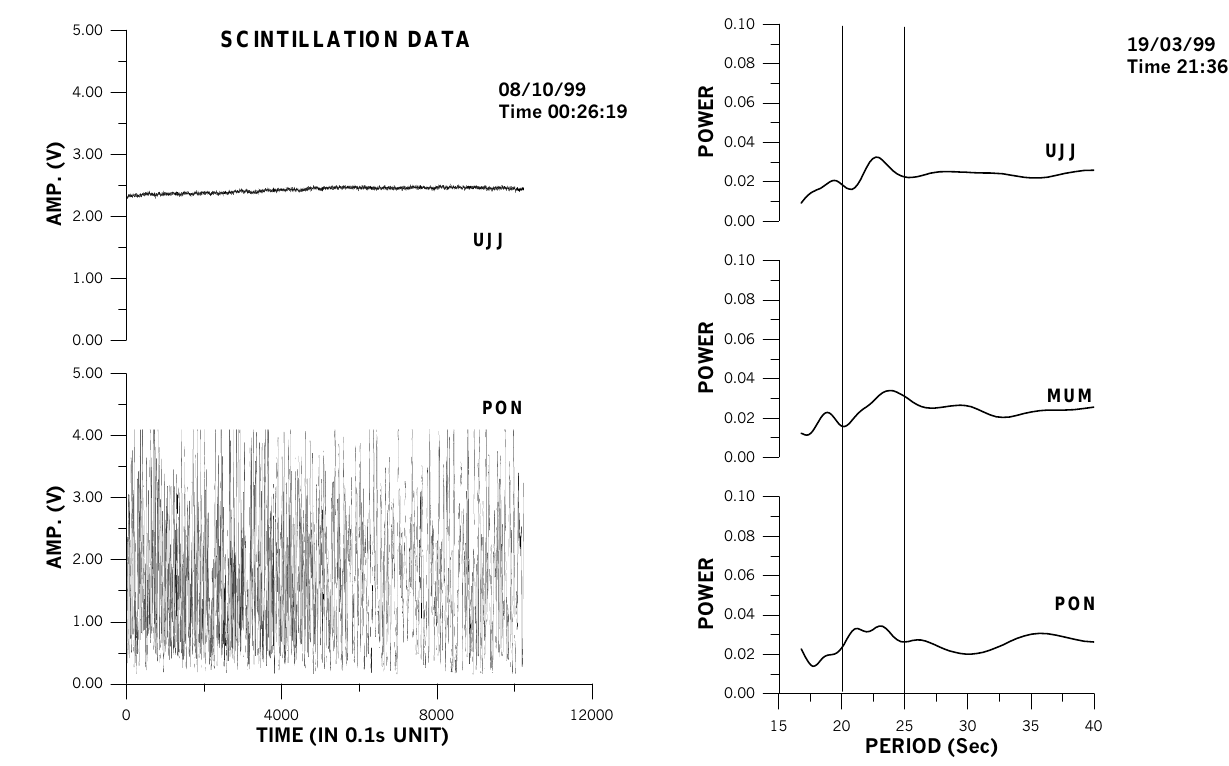
Fig. 6. Power spectrum of the 2 s averaged filtered scintillation on the specified day at local time and at the specified stations. The plot shows the spectral peaks clearly standing out around the eigen- period. The range of the eigen-period has been marked by the inter- val between two vertical